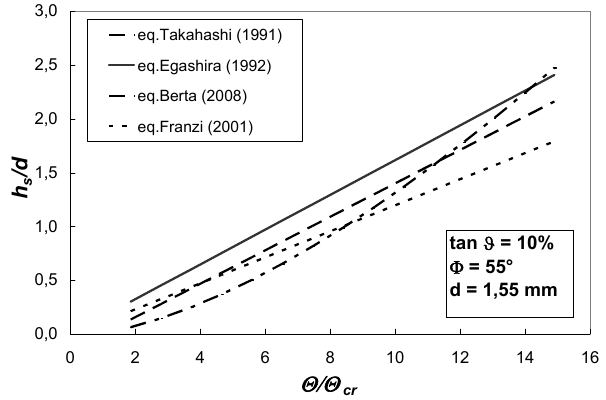
Fig. 2. Non-dimensional moving layer depth, h s /d , against 2/2 cr , estimated with different expressions developed for steady flows. Values of slope, friction angle and diameter used for the estimation are shown in the figure.